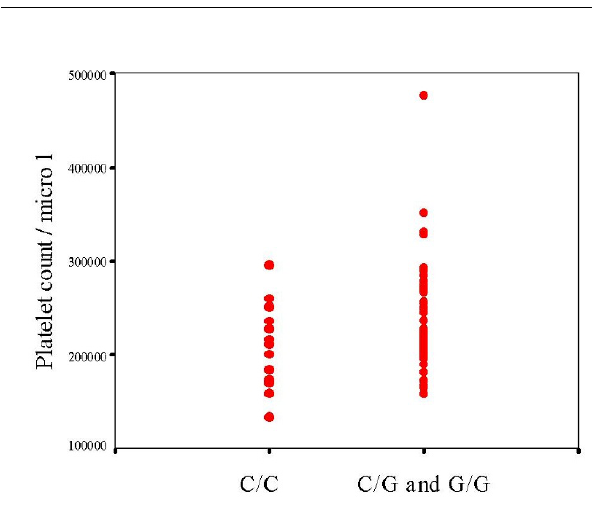
Figure 2 Peripheral platelet count according to interleukin-6 genotype. After excluding the outlier, the differences remained significant at a p =